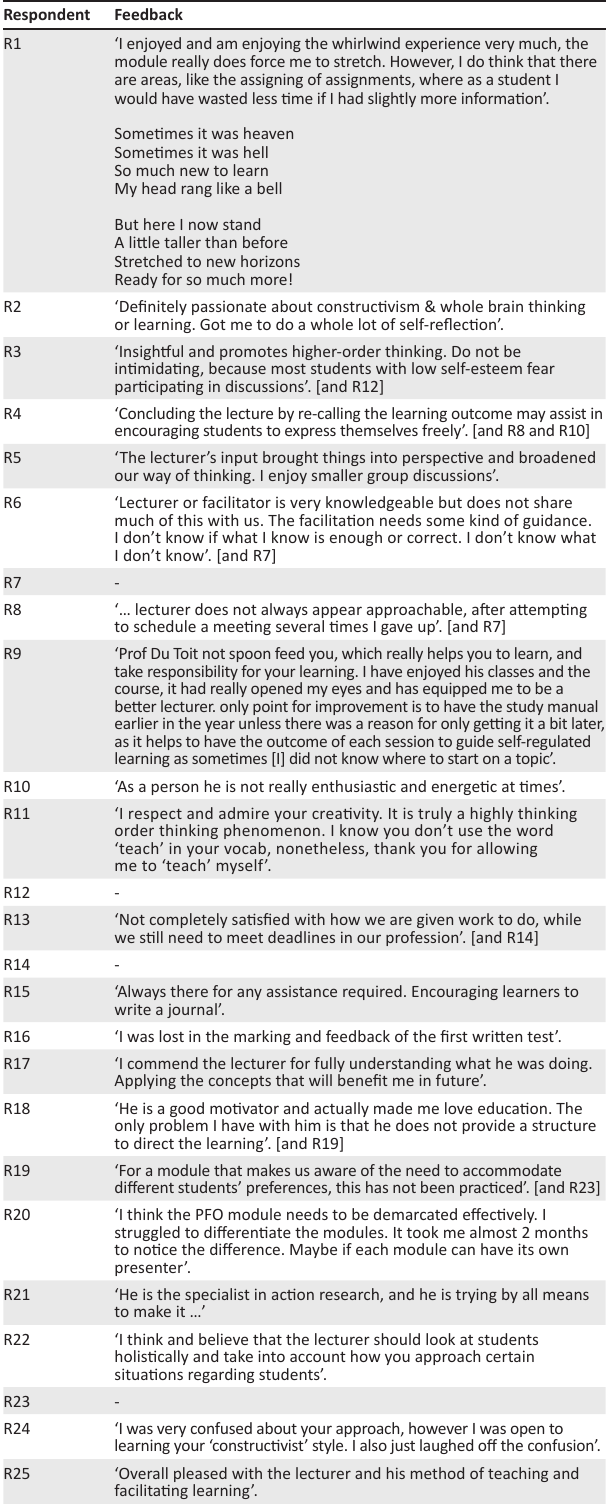
TABLE 1: Qualitative feedback of Postgraduate Certificate in Higher Education students on my facilitating learning. Respondent